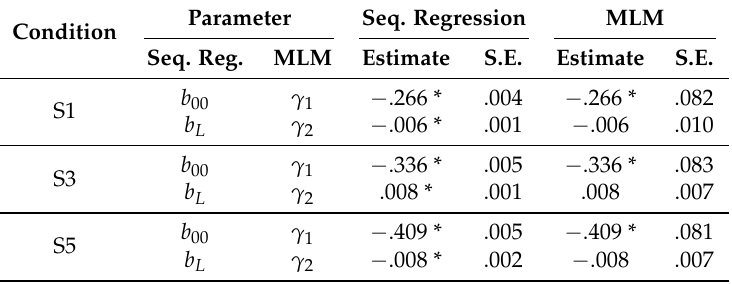
Table 5. Estimated parameters from WPA with z-standardized RTs as DVs.